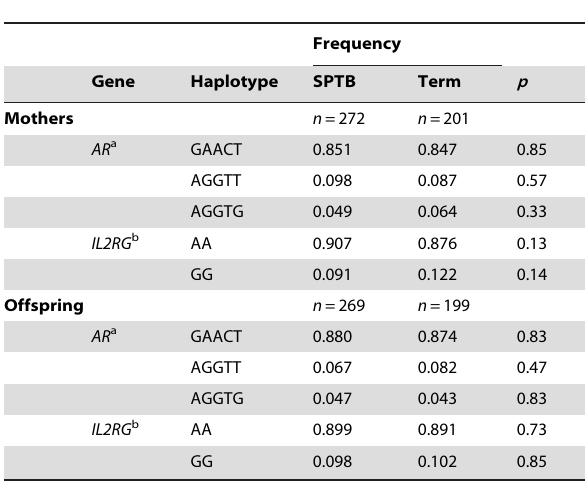
Table 4. Association analysis of AR and IL2RG haplotypes in SPTB in the initial case-control